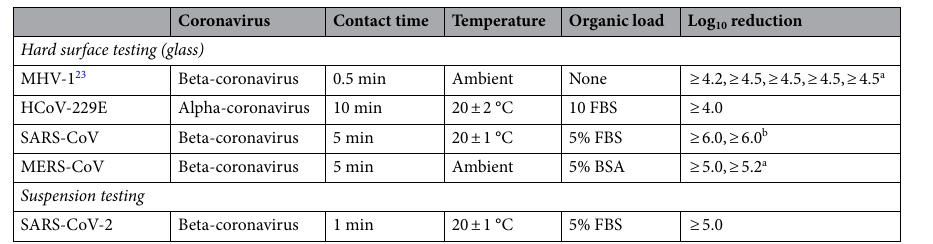
Table 2. Virucidal efficacy of an antiseptic liquid contining ~ 0.12% p -chloro- m -xylenol (PCMX) for inactivating a variety of coronaviruses in suspension or on a hard surface (glass). Abbreviations used: